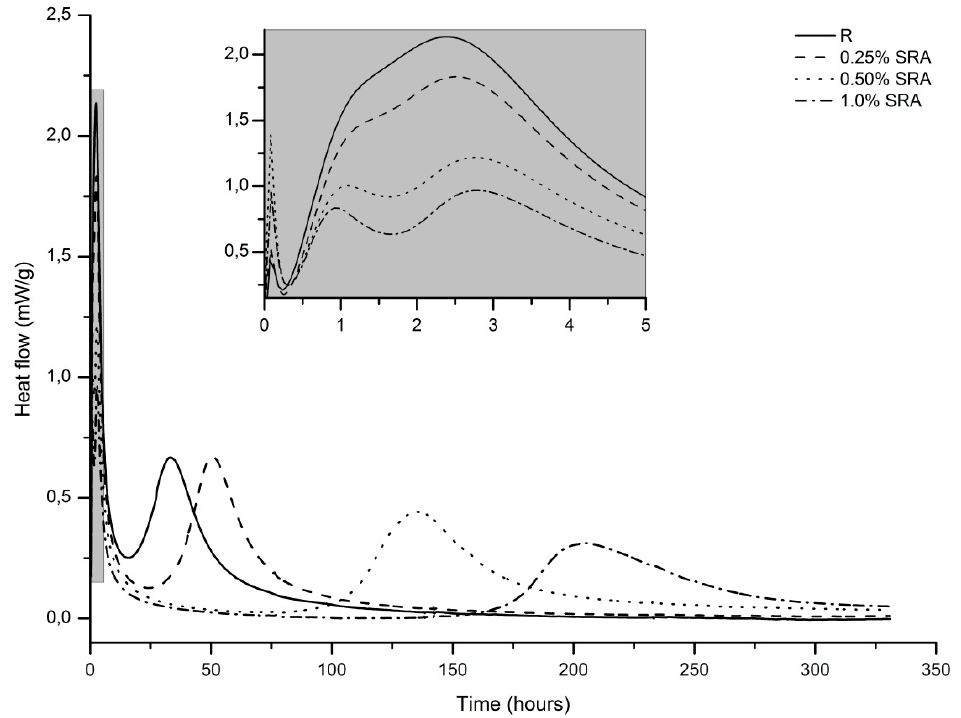
Figure 3. Effect of SRA on hydration heat evolution of AAS pastes.